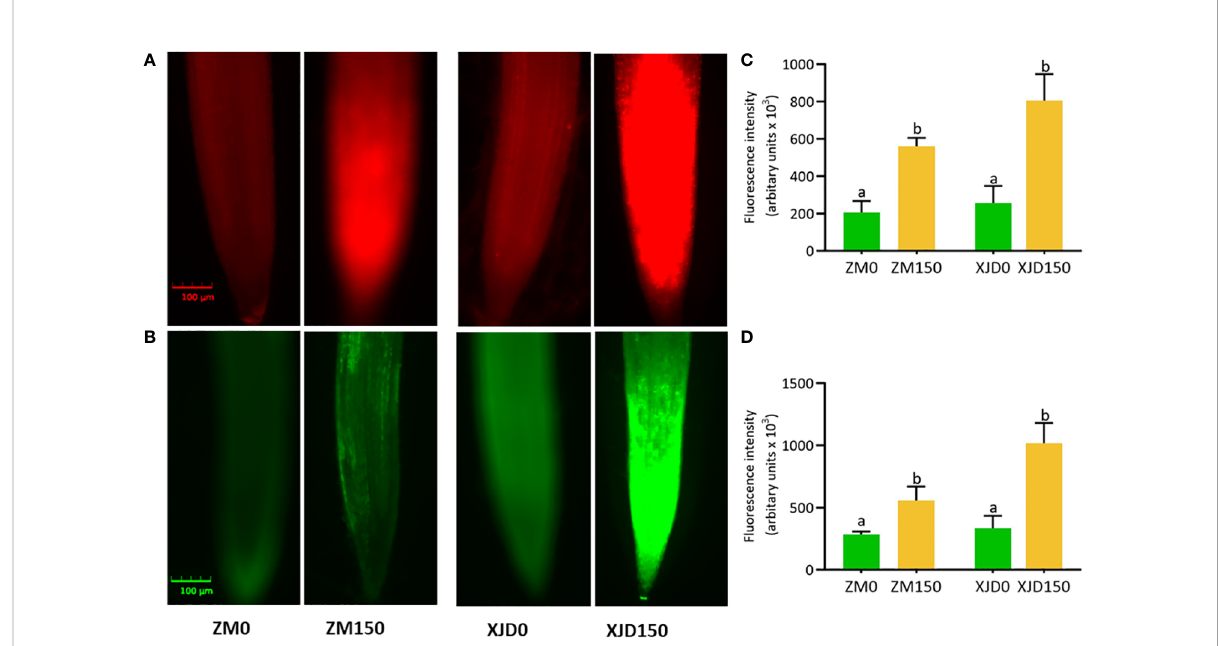
FIGURE 2 Accumulation of superoxide radical (O (cid:129) − 2 ) and hydrogen peroxide (H 2 O 2 ) in two contrasting alfalfa roots in response to salt stress. Visualization of fi c probe dihydroethidium (DHE) (A) and H fi c probe 2,7-dichloro fl uorescein diacetate (DCF-DA) in root tips (B) . fl uorescence of O (cid:129) − 2 O 2 -speci 2 -speci Fluorescence intensity of O (cid:129) − 2 (C) , and H 2 O 2 (D) . The O (cid:129) − 2 and H 2 O 2 are automatically measured by fl orescent microscope (CLS-01-00076,